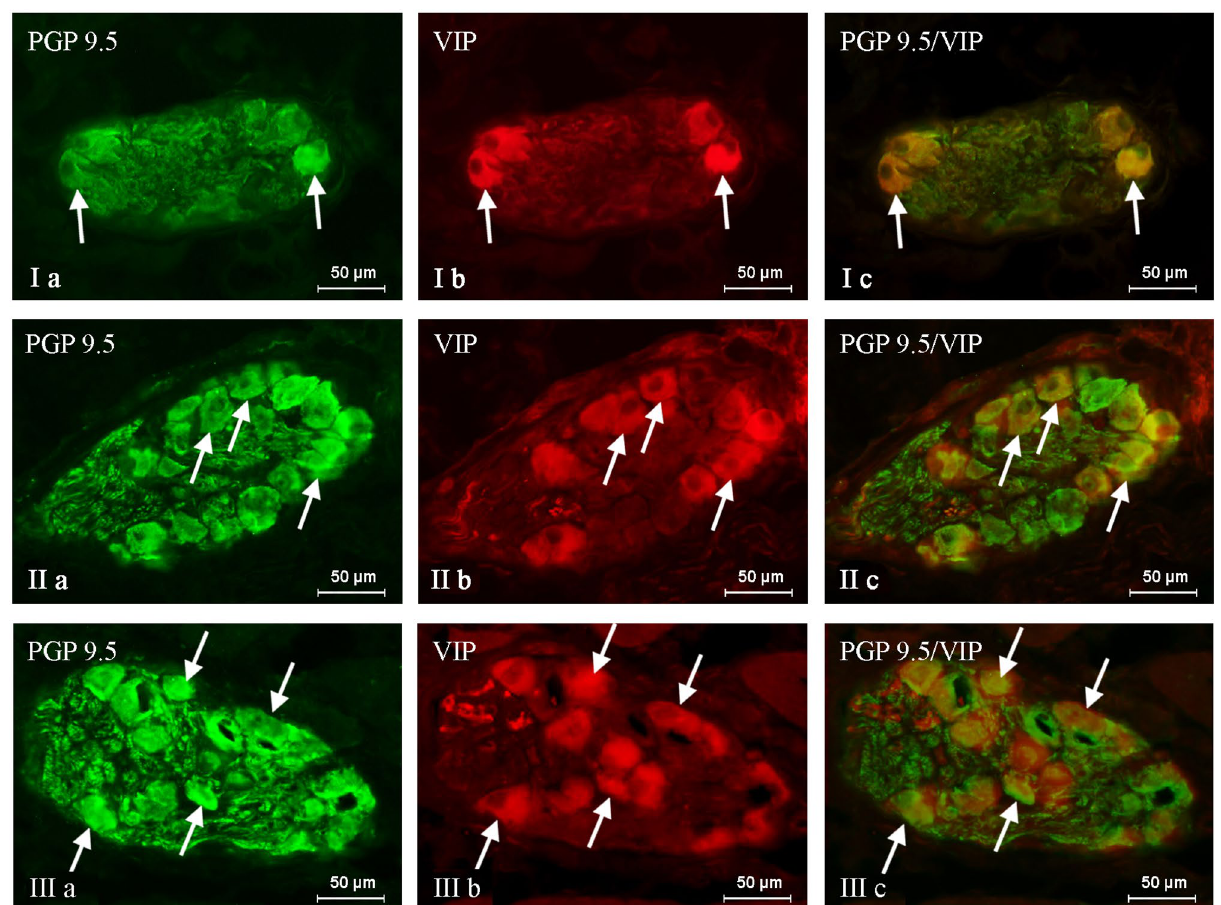
Figure 1. Neurons immunoreactive to protein gene product (PGP 9.5—green)—used here as a pan-neuronal marker and vasoactive intestinal polypeptide (VIP—red) in the intramural ganglia of the porcine urinary bladder trigone under physiological conditions—group C (I), under the influence of BPA in a dose of 0.05 mg/ kg body weight/day—group I (II) and under the influence of BPA in a dose of 0.5 mg/kg b.w./day—group II (III). VIP—positive neurons are marked with arrows. The right column ( c ) was created by overlapping pictures ( a ) and ( b ).